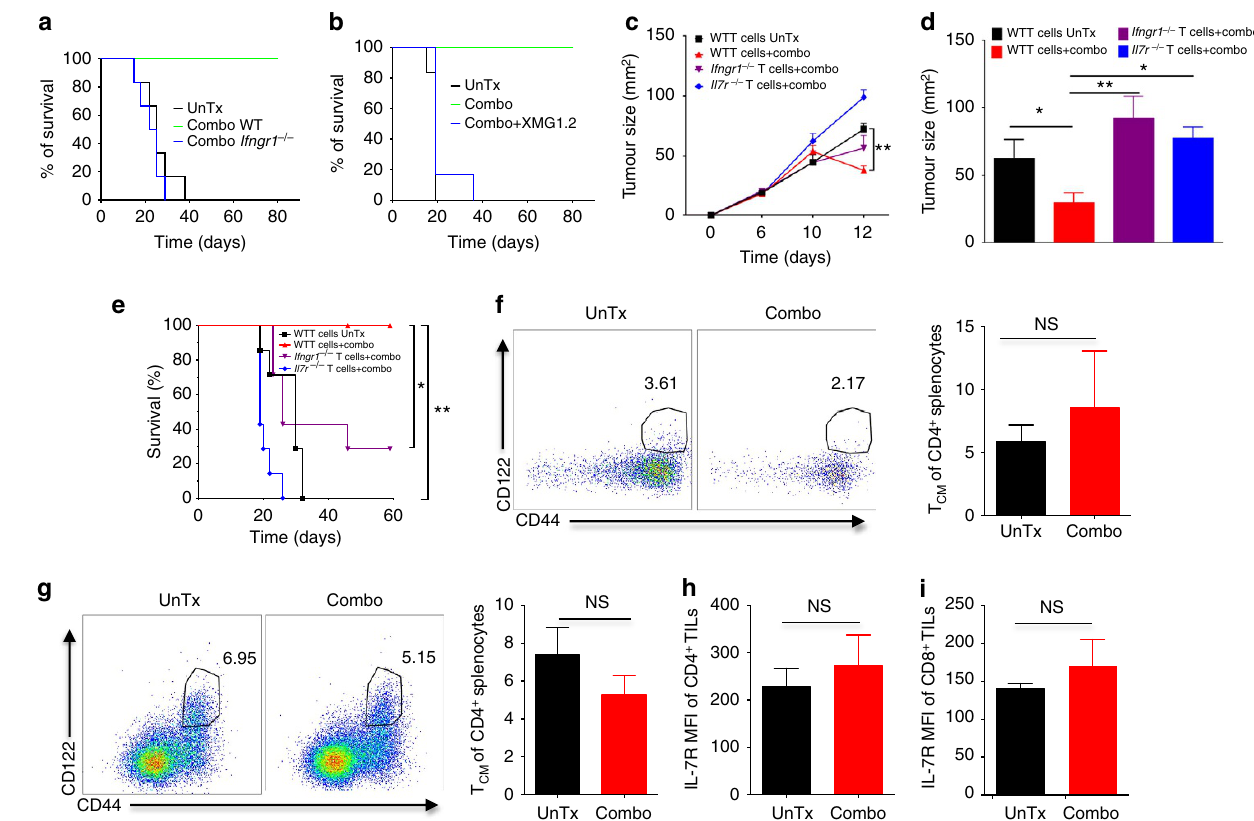
Figure 6 | Combination therapy requires an intact loop of IL-7 and IFN- c signalling pathways to reject MB49 tumours. ( a ) Survival of WT and Ifngr1 (cid:3) / (cid:3) MB49 tumour-bearing mice untreated (UnTx) or treated with combo. ( b ) Survival of tumour-bearing mice pretreated with blocking antibody against IFN- g (XMG1.2) and then treated with combination therapy. ( c ) Sublethally irradiated CD45.1 mice were adoptively transferred with WT, Ifngr1 (cid:3) / (cid:3) or Il7r (cid:3) / (cid:3) total T cells, followed by MB49 tumour inoculation and combination therapy. Tumour growth kinetics is shown. ( d ) Rag-1 (cid:3) / (cid:3) mice were adoptively transferred with WT, Ifngr1 (cid:3) / (cid:3) or Il7r (cid:3) / (cid:3) total Tcells, followed by MB49 tumour inoculation and combination therapy. Tumour sizes on day 12 post-tumour inoculation are shown. ( e ) CD45.1 mice were treated as described above in c and mouse survivals are illustrated. ( f , g ) Isolated splenocytes from Il7r (cid:3) / (cid:3) ( f ) and Ifngr1 (cid:3) / (cid:3) ( g ) tumour-bearing mice as described in Fig. 3 were analyzed for frequencies of CD4 þ CD44 hi CD122 þ ( T CM ) cells. Pooled results from five mice are depicted as bar graphs. ( h , i ) Isolated TILs from Ifngr1 (cid:3) / (cid:3) tumour-bearing mice treated with combination therapy were examined one-way ANOVA with Bonferroni’s post hoc test ( c , d ), log-rank (Mantel–Cox) test ( e ) or two-tailed unpaired Student’s t -test ( f – i ). Data are